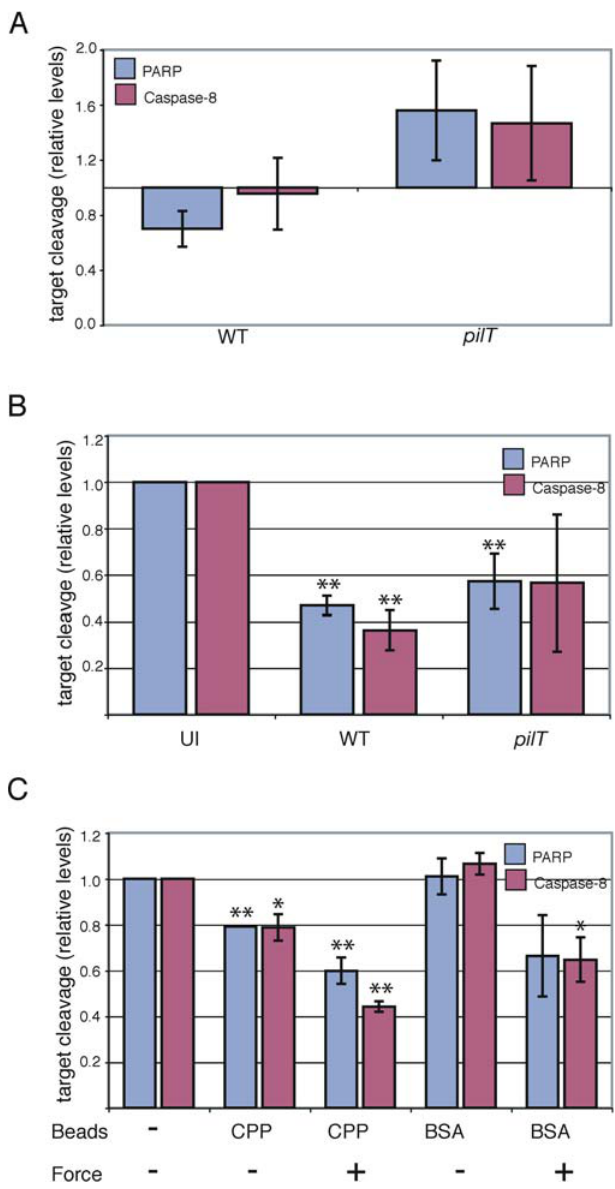
Figure 5. Pilus Retraction during Bacterial Attachment Promotes Host Cell Cytoprotection (A) Levels of cleaved PARP and cleaved caspase 8 in T84 cells infected for 6 h with N400 (WT) or N400 pilT (pilT), normalized to cleaved PARP or cleaved caspase 8 levels in uninfected cells. (B) Levels of cleaved PARP and cleaved caspase 8 in T84 cells infected with N400 (WT) or N400 pilT (pilT) or left uninfected (UI) for 4 h, then incubated with STS (1 l M) for an additional 4 h to induce apoptosis. A significant difference from uninfected cells is denoted by two asterisks ( p , 0.05). (C) Cleaved PARP and cleaved caspase 8 levels in cells exposed to magnetic force. T84 cells were seeded with CPP- or BSA-coated beads and exposed to the magnet for 2 h or were left unexposed, then incubated with STS (1 l M) for an additional 4 h away from the magnet. The cleaved PARP and cleaved caspase 8 level in cells without beads and not exposed to magnetic force is arbitrarily assigned a value of 1.0, and all other treatments are expressed relative to this value. For all experiments, cleaved protein levels were quantified by densitometry of immunoblot signals. Values represent the mean levels of cleaved target ( 6 SEM) from two independent experiments. A significant difference from untreated cells is denoted by two asterisks ( p , 0.05) or by a single asterisk ( p , 0.1). DOI: